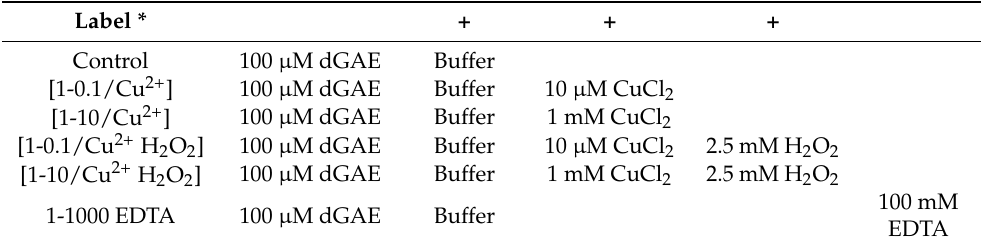
Table 1. dGAE conditions with and without oxidation. Label